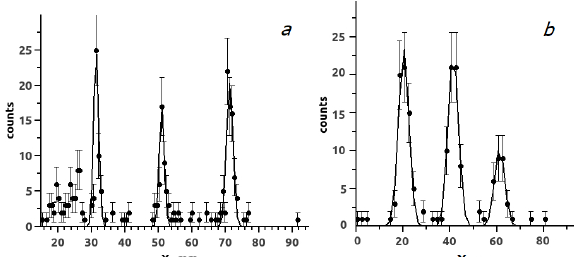
Fig. 2. Neutron coordinate distribution measured in the 10 B detector at U = 700 V with Cd-mask along: (a) X-axis; (b) Y- axis .